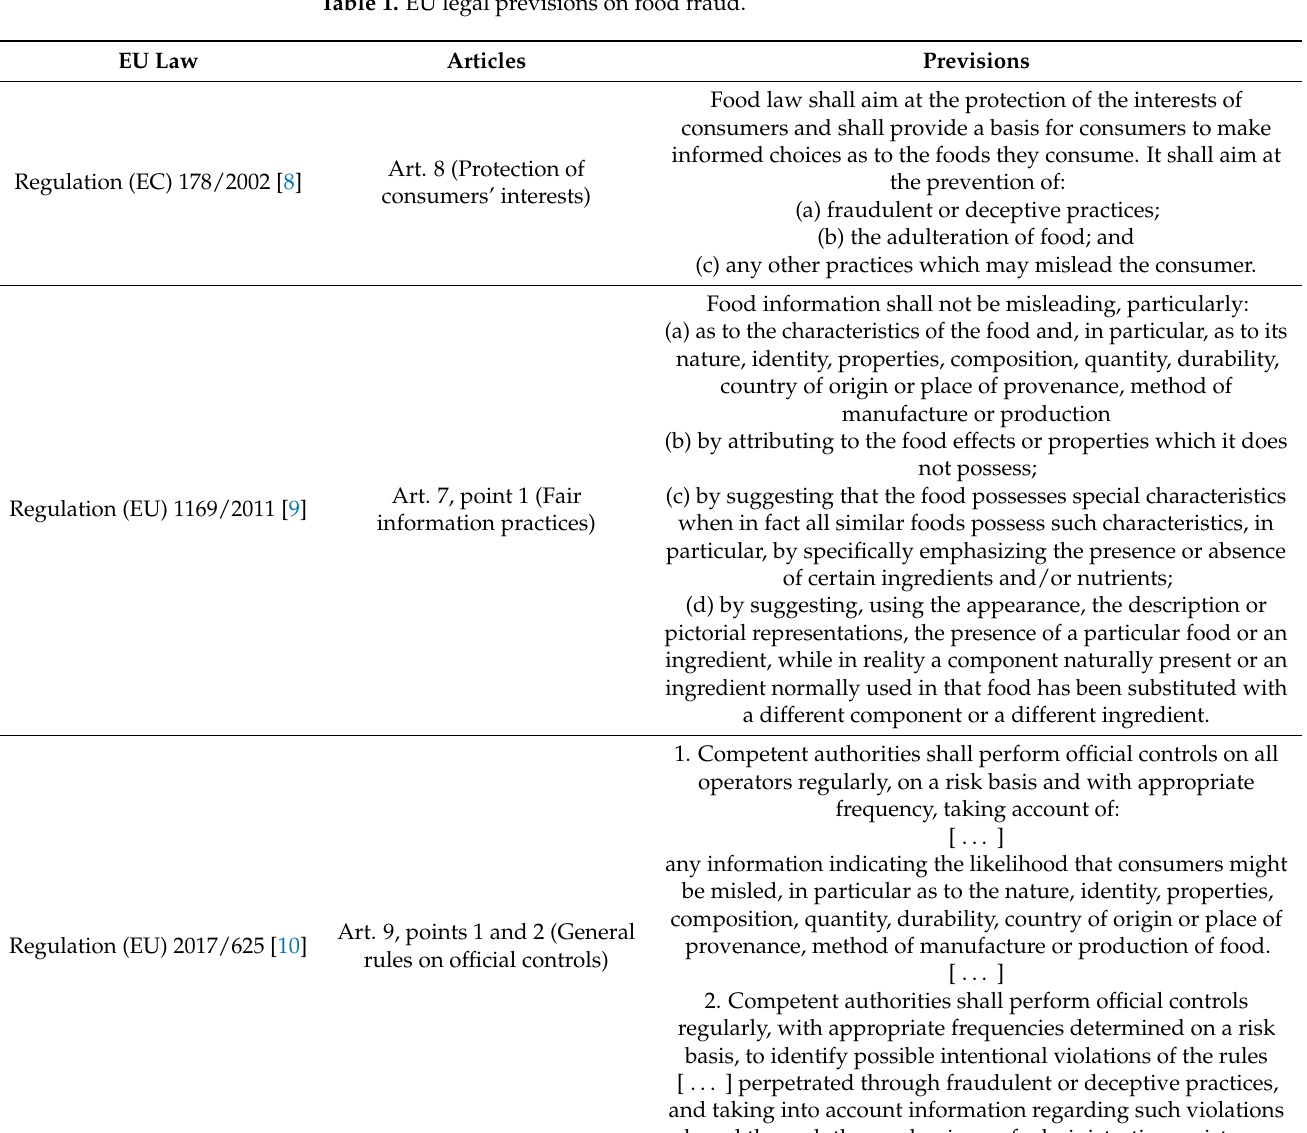
Table 1. EU legal previsions on food